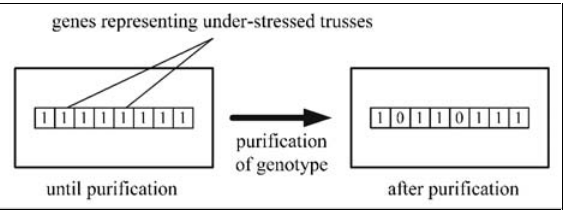
Fig. 12. Purification of genotype